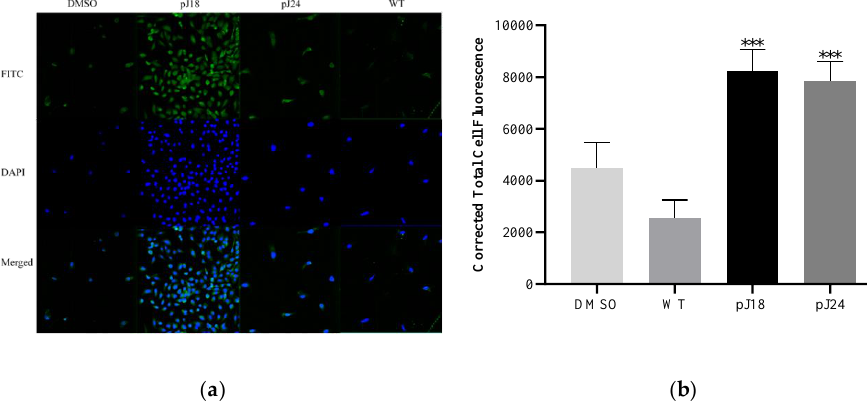
Figure 1. Fluorescent microscopy of phage binding to SKOV 3 cells. ( a ) Cells were incubated with 10 11 V / mL pJ18, pJ24, wild type (WT), or dimethyl sulfoxide (DMSO) (vehicle) and probed by a biotinylated anti-Fd filamentous phage antibody and streptavidin-fluorescein isothiocyanate (FITC). Cells were